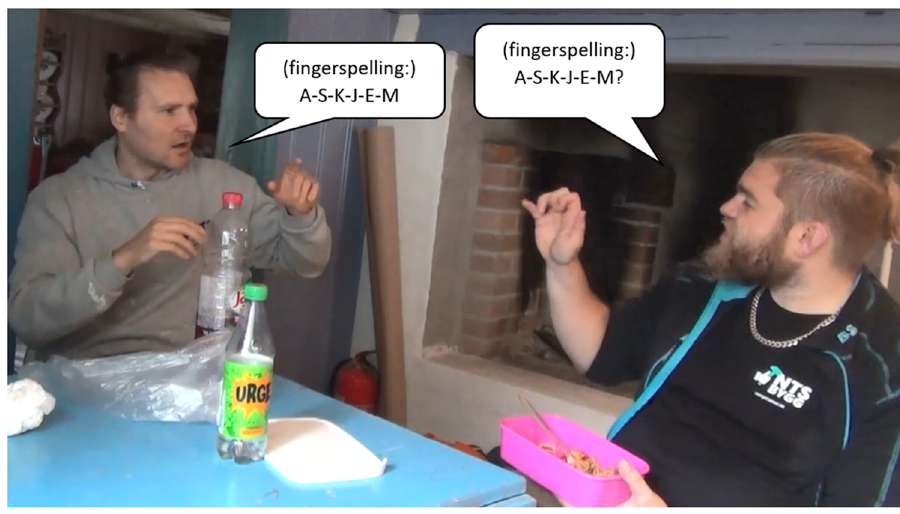
Figure 6: Ben ’ s ( left ) overlapping con fi rmation of Abe ’ s fi nger spelling. ( Lines 12 and 13. )